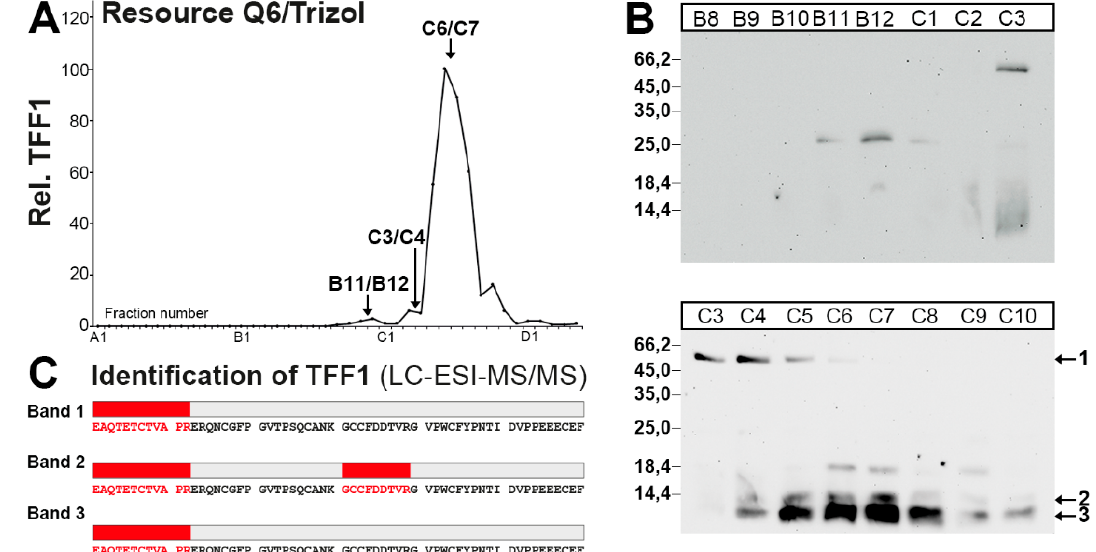
Figure 4. Purification of the 60k-band and monomeric forms of TFF1 from a human gastric corpus extract (M C -577) after TRIzol ® extraction, and characterization by LC-ESI-MS / MS analysis. ( A ) Anion-exchange chromatography on a Resource Q6 column of a human gastric extract (M C -577) after TRIzol ® extraction. Shown is the distribution of the relative TFF1 immunoreactivity in the fractions as determined by Western blot analysis under reducing conditions and semi-quantitative analysis of the typical monomeric band intensities. ( B ) 15% SDS-PAGE (non-reducing conditions) and subsequent Western blot analysis of the fractions B8-C10 concerning TFF1 (post-in-gel reduction). Marked are the band at 60k (band 1) and the monomeric bands 2 and 3. The molecular mass standard is indicated on the left. ( C ) Fractions C3 / C4 and C6 / C7 respectively, were concentrated, desalted, separated by non-reducing 15% SDS-PAGE followed by Coomassie staining, and the regions corresponding to bands 1–3 were excised and subjected to LC-ESI-MS / MS analysis. Shown are the results of the LC-ESI-MS / MS analysis after tryptic in-gel digestion of the bands 1–3. Identified tryptic peptides belonging to TFF1 are shown in red.